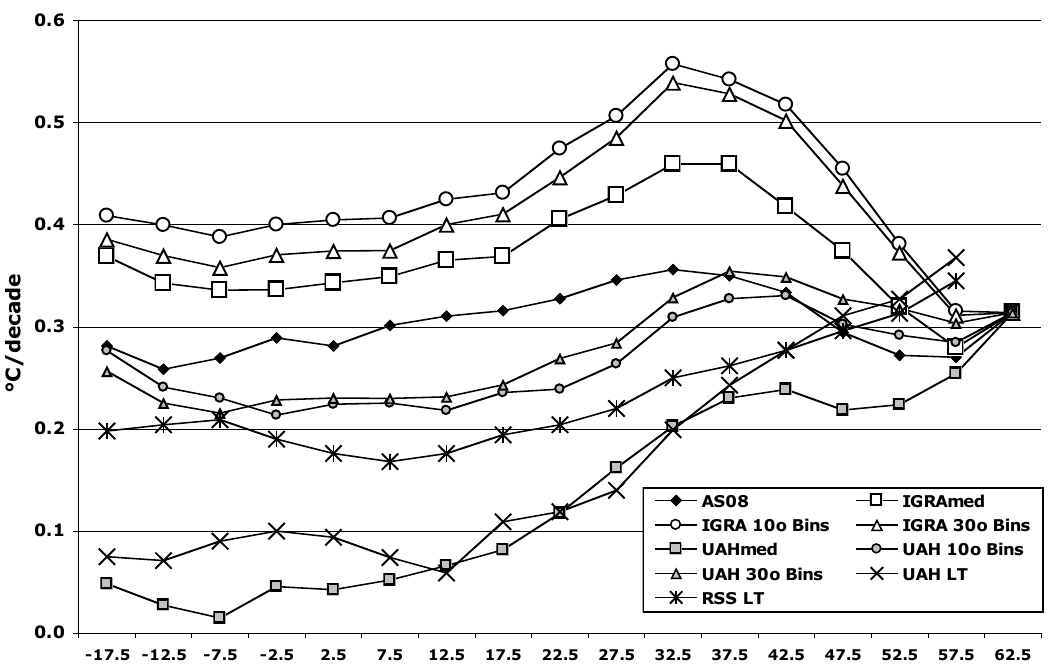
Figure 8. Temperature trends of T by various TWE calculations as well as direct satellite LT (UAH and RSS) measurements tied to 62.5°N as the starting integration point. LT Latitude Trends 1979-2005